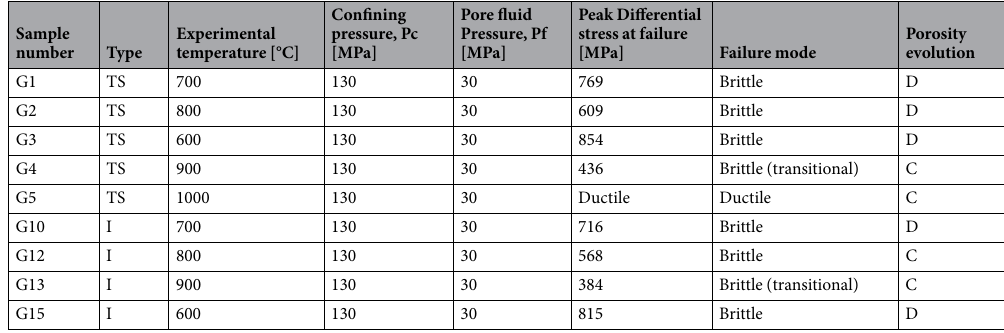
Table 1. Summary of experimental conditions and results. TS – sample thermally-shocked to 450 °C; I – initially-intact sample; D – dilation; C – compaction.